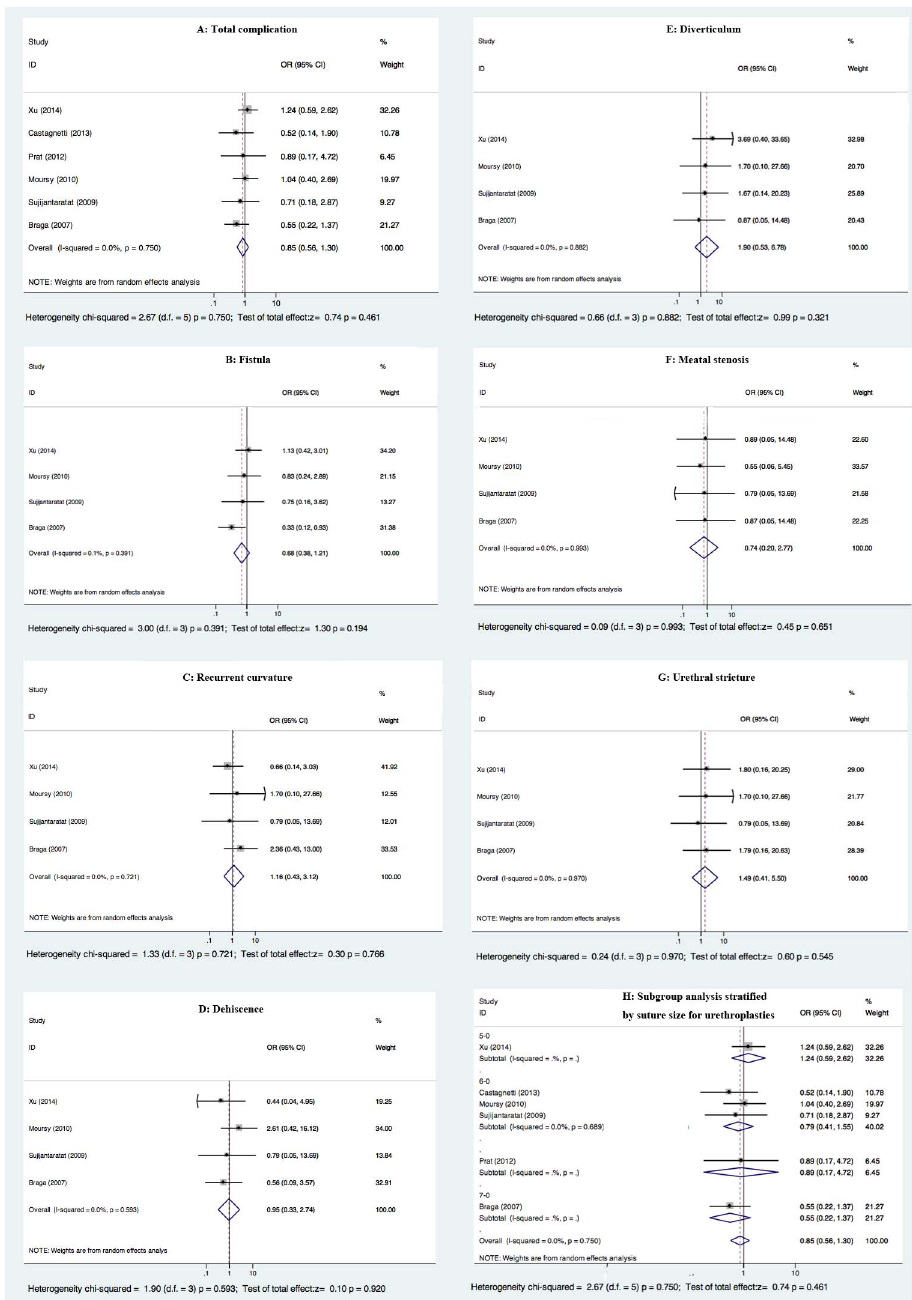
Figure 2. Forest plots of postoperative complications between TVIF onlay and TIP.